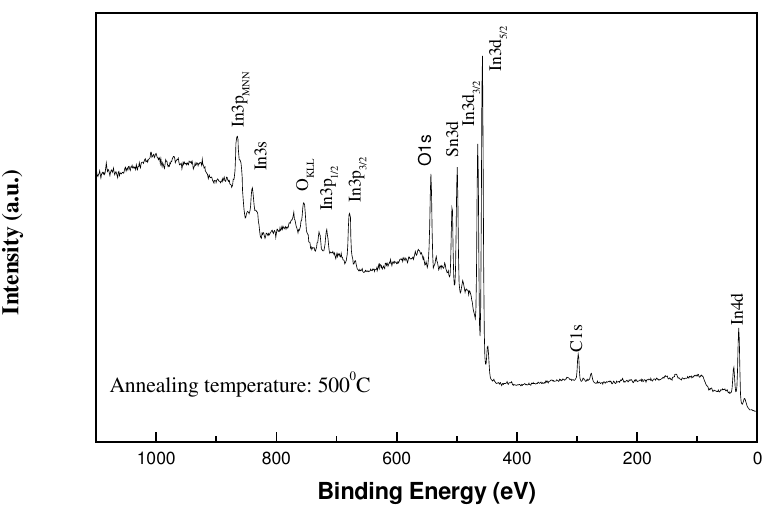
Figure 4 . XPS result of the obtained sample annealed at 500 (cid:176) C for 45min XPS